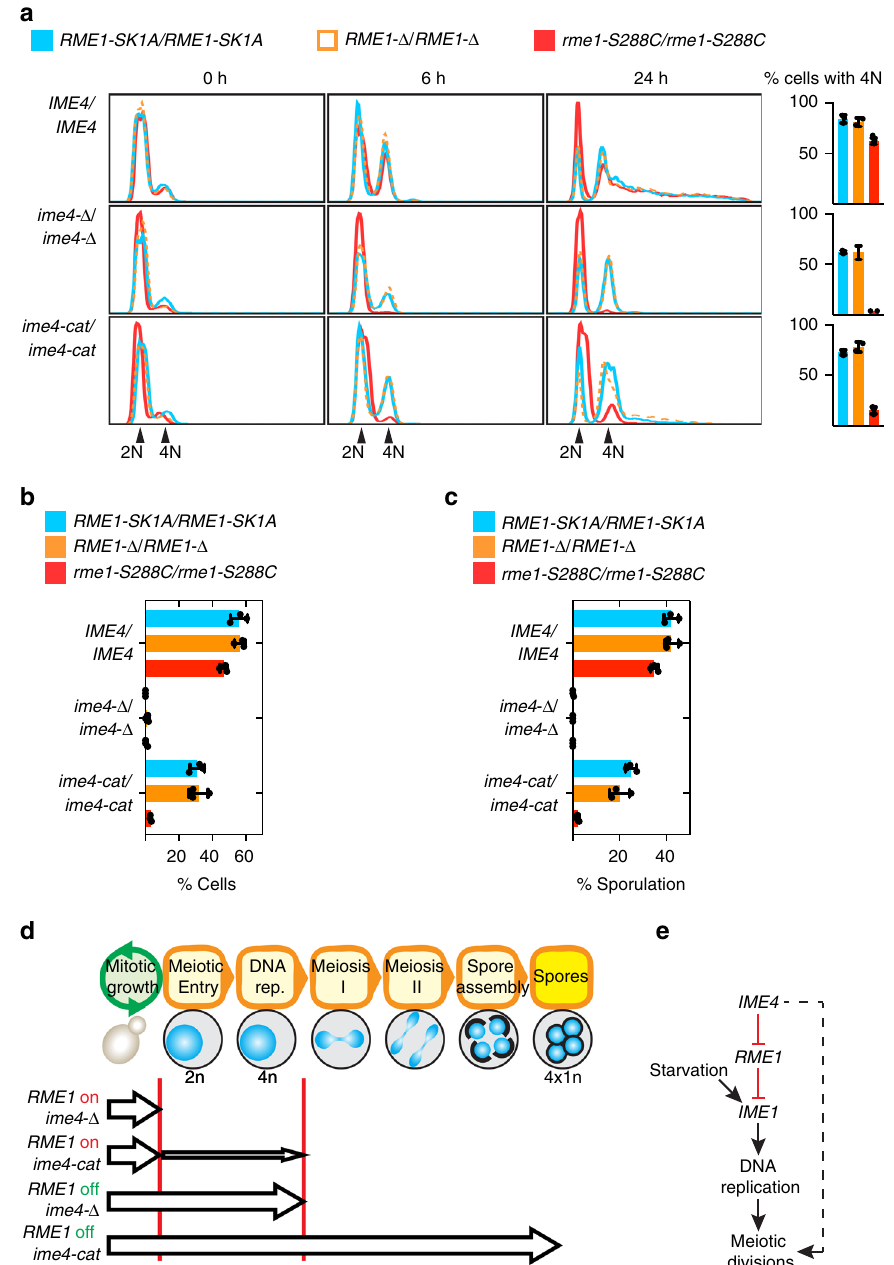
Fig. 3 IME4 m 6 A is required for meiotic DNA replication, and a non-m 6 A function is required for meiotic divisions. a Flow cytometric analysis of DNA content in IME4 and ime4 mutants (rows) in three color-coded RME1 allele backgrounds over a meiotic time course (columns). A quanti fi cation of the 24-h time point is on the right of each row. Percentage of cells with 4 N includes both sporulated and non-sporulated cells. Means, individual values, and s.d. from two to fi ve experiments. Source data are provided in a Source Data fi le. b Meiotic nuclear divisions in IME4 and ime4 mutants in three color-coded RME1 allele backgrounds as assayed by DAPI staining of nuclei after 24 h in SPO medium. The percentage of cells with two or more nuclei is indicated on the horizontal axis. Means, individual values, and s.d. from three experiments. At least 200 cells were counted per strain per experiment. Source data are provided in a Source Data fi le. c Sporulation after 48 h in SPO media in IME4 and ime4 mutants in three color-coded RME1 allele backgrounds as scored by light microscopy. Means, individual values, and s.d. from three experiments. At least 200 cells were counted per strain per experiment. Source data are provided in a Source Data fi le. d A model depicting the various points along the S. cerevisiae meiotic program in which different IME4 functions are needed in different RME1 backgrounds. “ RME1 on ” denotes the highly expressed rme1-S288C allele, while “ RME1 off ” denotes either the hypomorph RME1-SK1A or RME1- Δ . Arrows represent an ability to progress through the various landmarks that appear at the top, while vertical red lines indicate an inability to progress further. e A model for the functions of IME4 in meiosis: IME4 promotes meiotic DNA replication by repression of RME1 , which represses the master activator of meiosis, IME1 . IME1 is also activated by nutritional signals. IME4 has a second function downstream of IME1 in promoting meiotic divisions (dashed